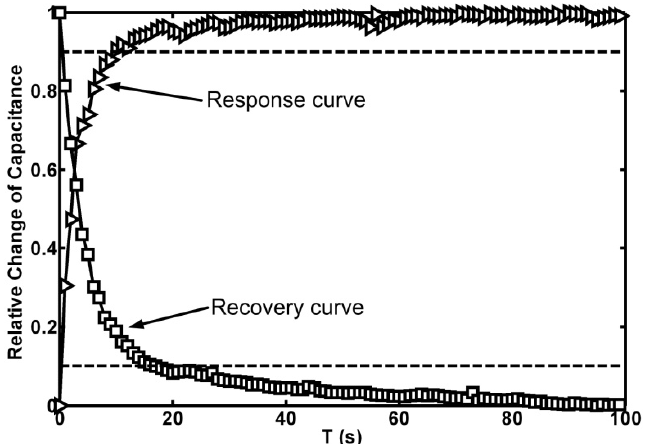
Figure 8. Dynamic test results of the sensor at 25 °C.